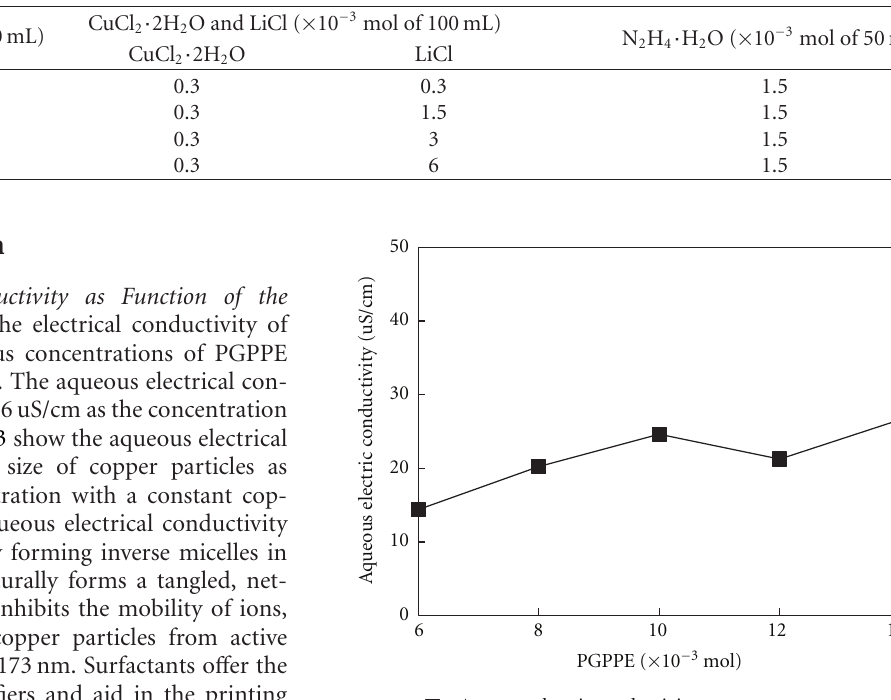
Table 3: Specifications of each solution with varying lithium ion concentrations.